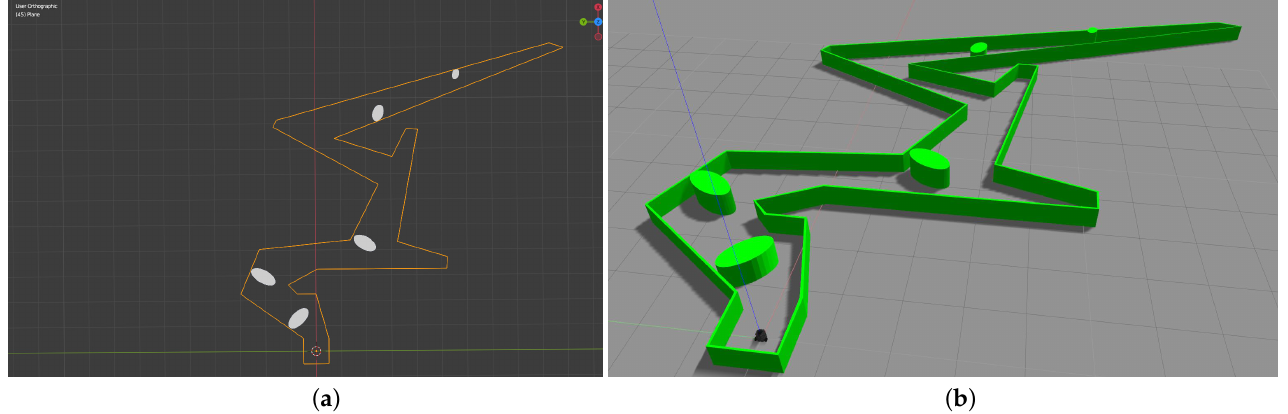
Figure 9. Circuit used in the usability and presence tests. ( a ) Blender-made circuit. ( b ) Gazebo